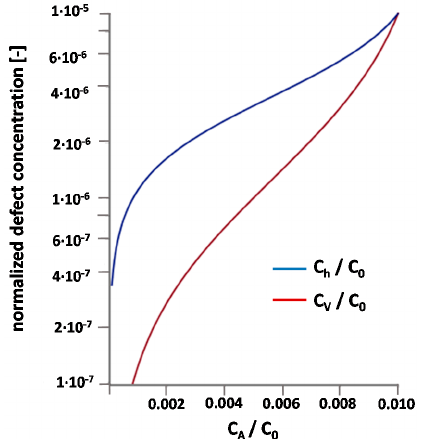
Figure 14. Concentrations of oxygen vacancies and holes for different acceptor concentrations. All concentrations are normalized to a formula unit (concentration of ABO 3 cell = C 0 ) and calculated from Equation (13) with C T,tot / C 0 = 0.56 × 10 − 2 , K T = 0.8 × 10 11 × ( C 0 ) 2 , K (cid:48) δ = 1 × 10 5 × C 0